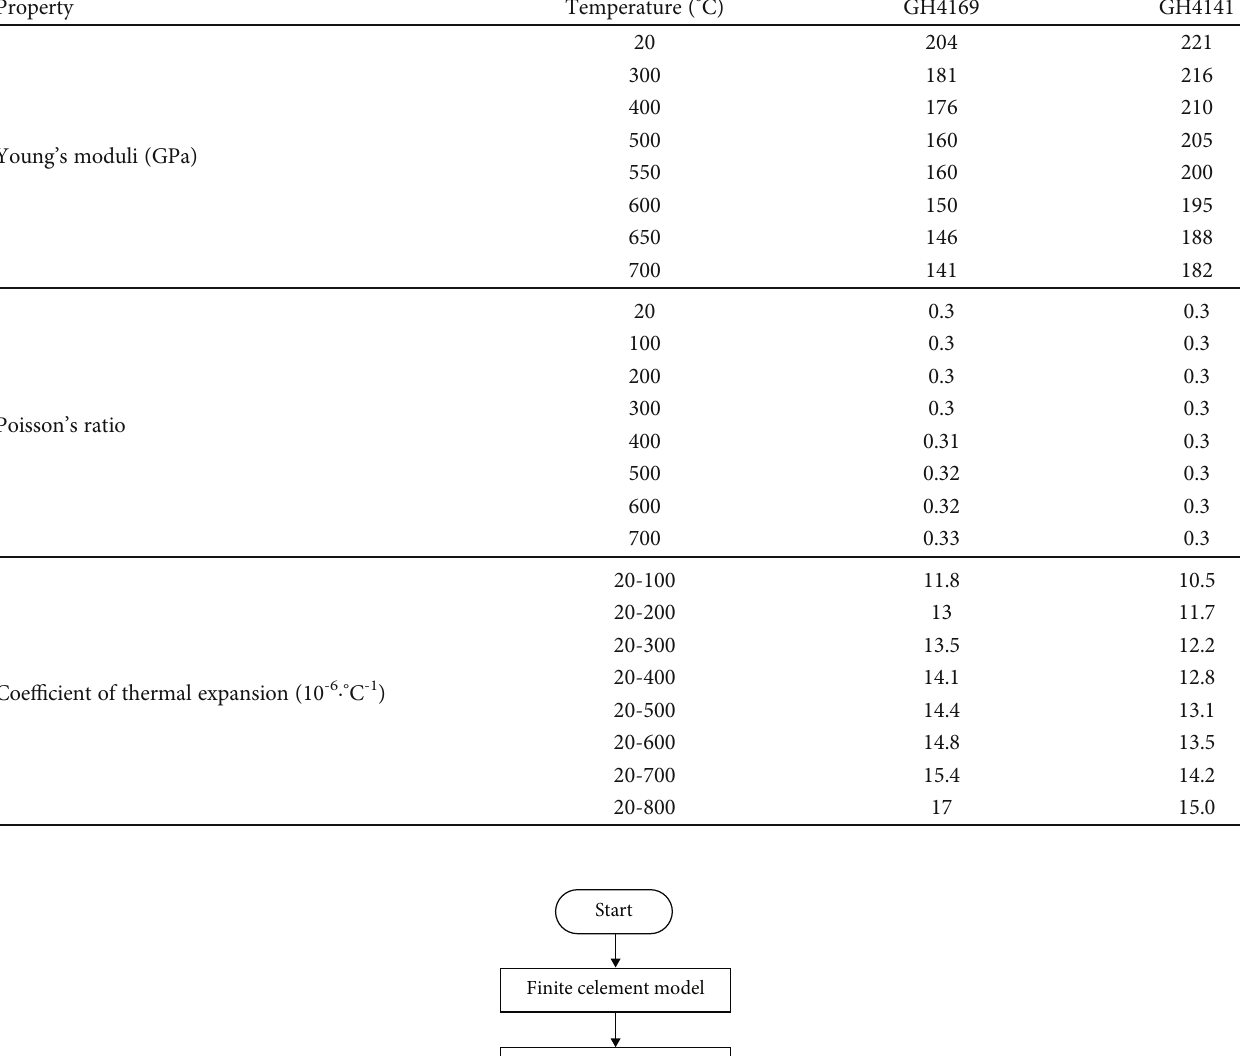
Table 2: Mechanical and thermal properties of superalloy plate and bolt/nut.